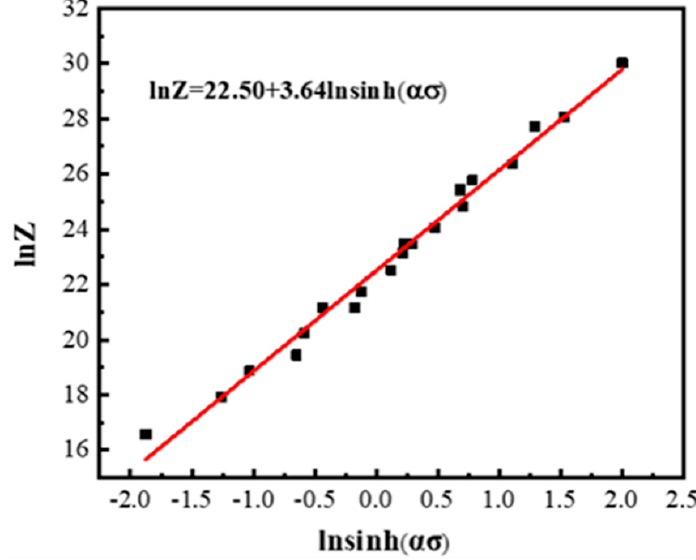
ε · · · ε - σ ε -ln σ ε -ln[sinh( α σ p , ( b ) ln p , ( c ) ln ε